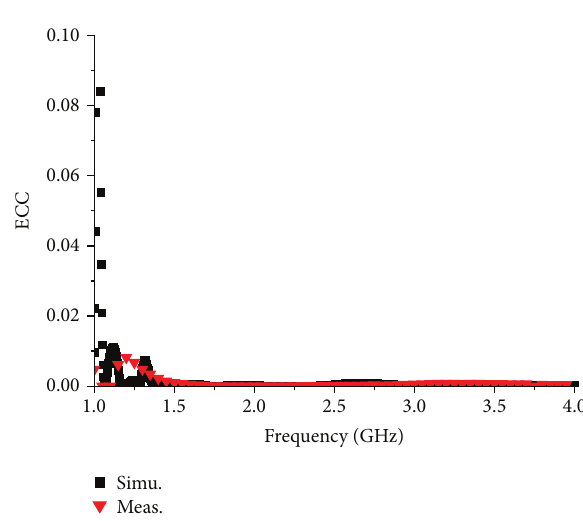
Figure 9: Simulated and measured ECCs of the proposed